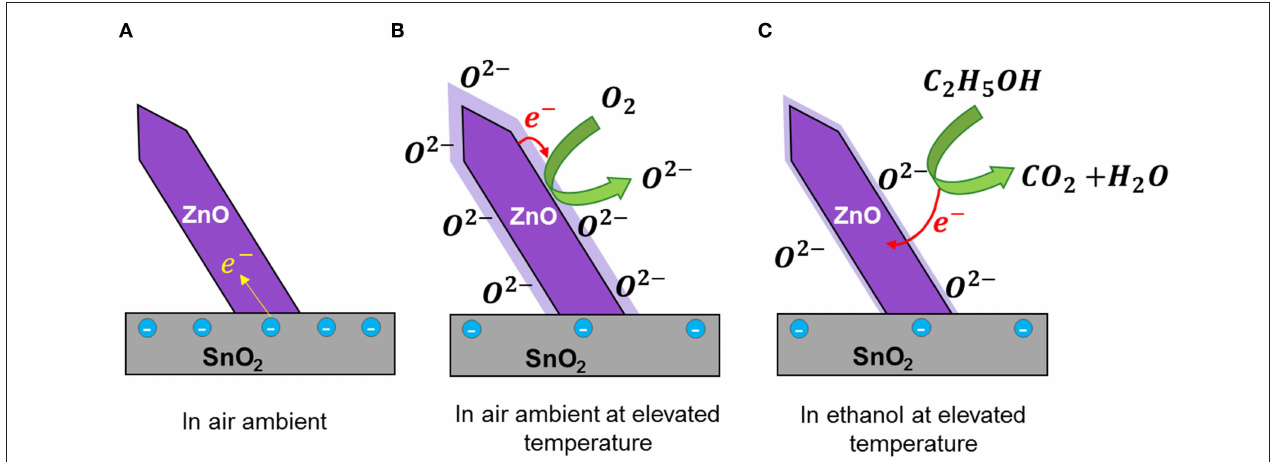
FIGURE 6 | Schematic ethanol sensing mechanism of ZnO nanorod on SnO 2 thin film (A) In air ambient, (B) In air ambient at elevated temperature, and (C) In ethanol at elevated temperature.